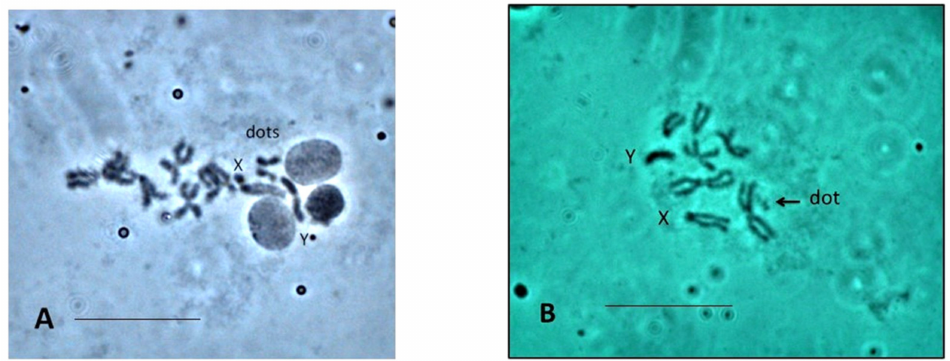
Figure 2. Cerebral ganglia squashes ( A ) Scaptodrosophila sp. aff. concolor strain CBR1, orcein squash, ‘dots’, X and Y indicated. ( B ) Scaptodrosophila xanthorrhoeae , orcein squash, ‘dot’, X and Y indicated. Bar = 5 µ